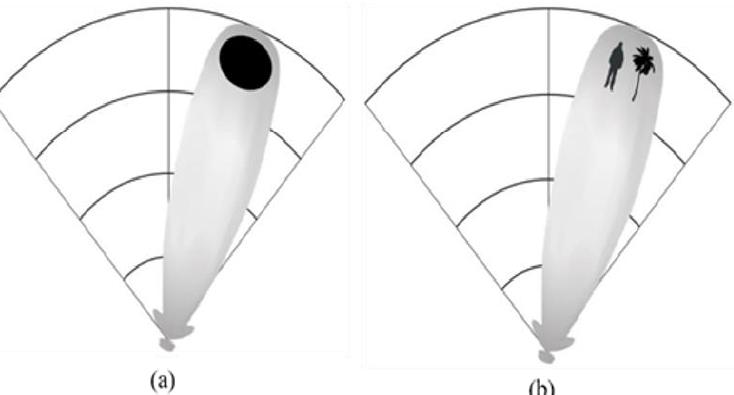
Figure 2. Azimuthal angle estimation: ( a ) conventional methods cannot estimate the angle of objects under a single beam; and ( b ) estimate of object’s angle under a single beam through the proposed methodology.